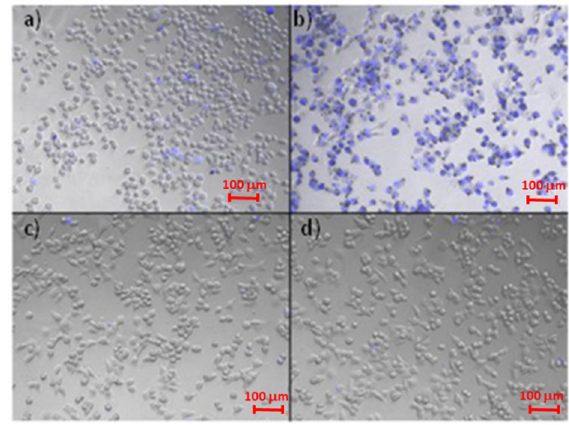
Figure 6. Microscope pictures of 16-HBE treated in di ff erent ways: ( a ) cells treated with PHEA -g- bAPAE in DPBS pH 7.4. ( b ) cells treated with PHEA -g- bAPAE in isotonic MES 20 mM pH 5, ( c ) cells treated with DPBS pH 7.4, ( d ) cells treated with isotonic MES 20 mM pH5.